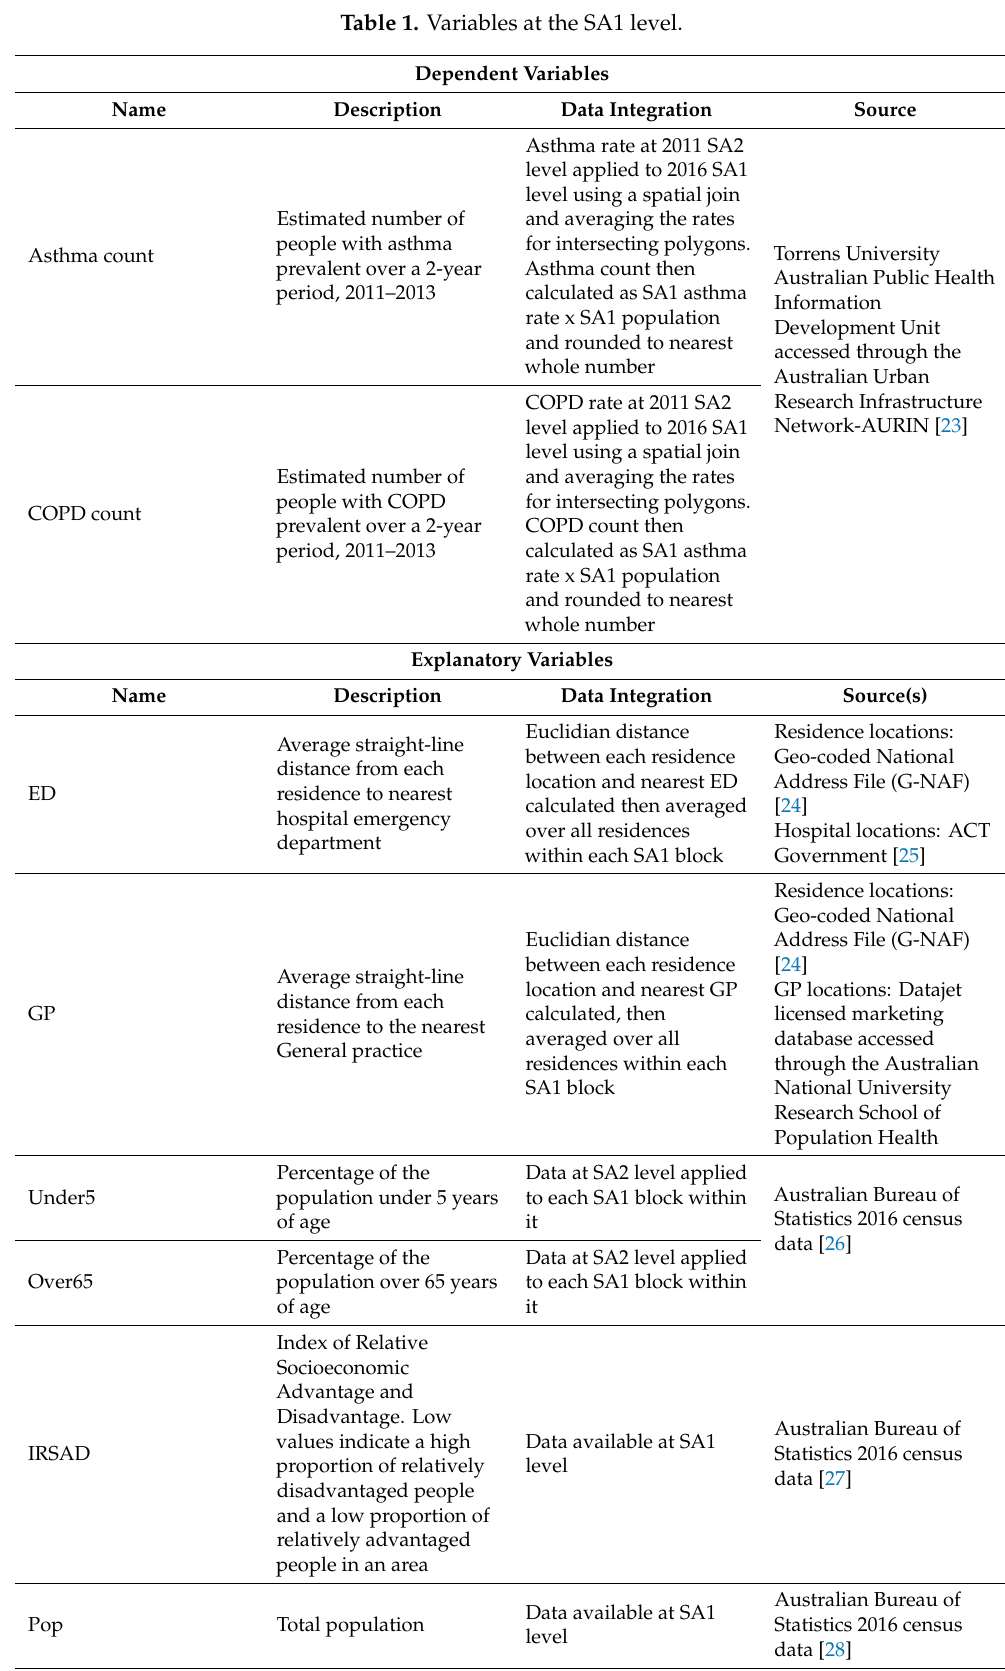
Table 1. Variables at the SA1